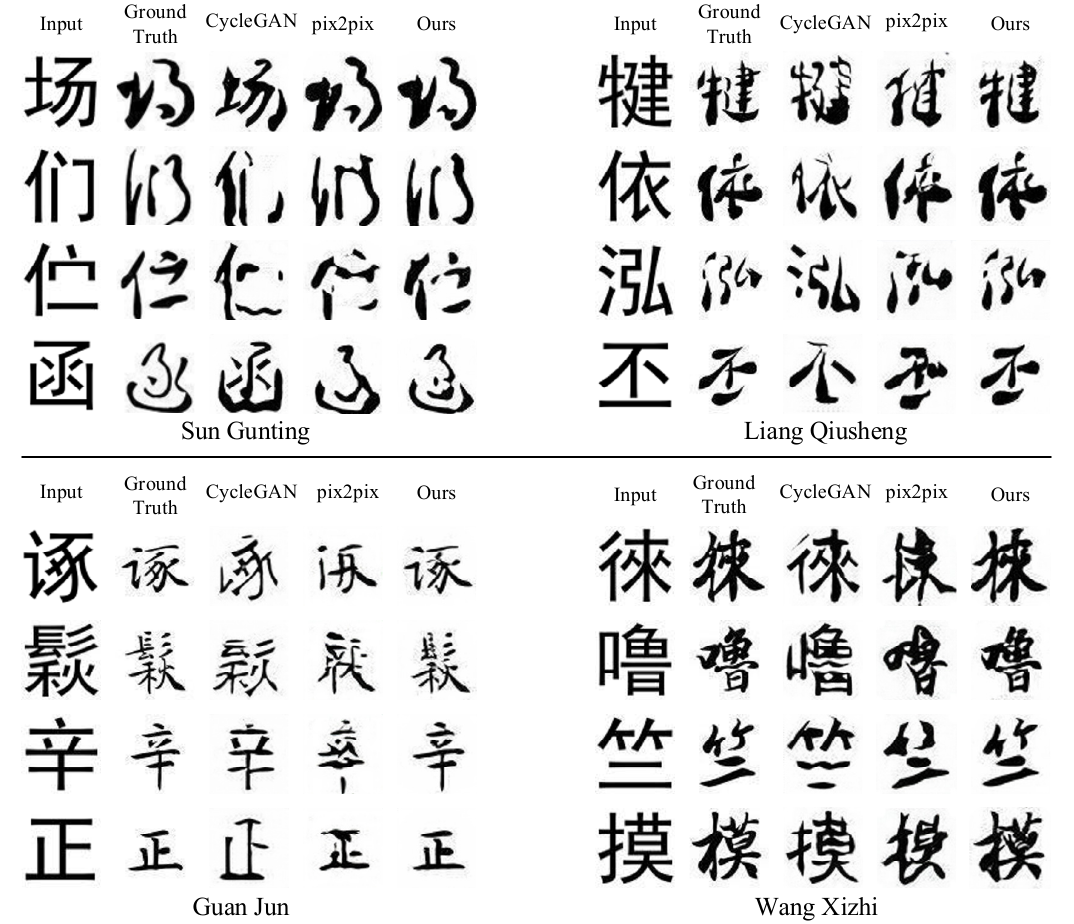
Figure 7. Example results of the baseline methods and our method on the same dataset.